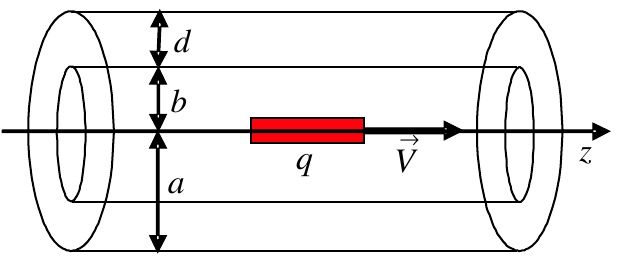
FIG. 1. (Color) Geometry of the problem. The bunch moves along the axis of the waveguide with an active medium cylin- drical layer of thickness d